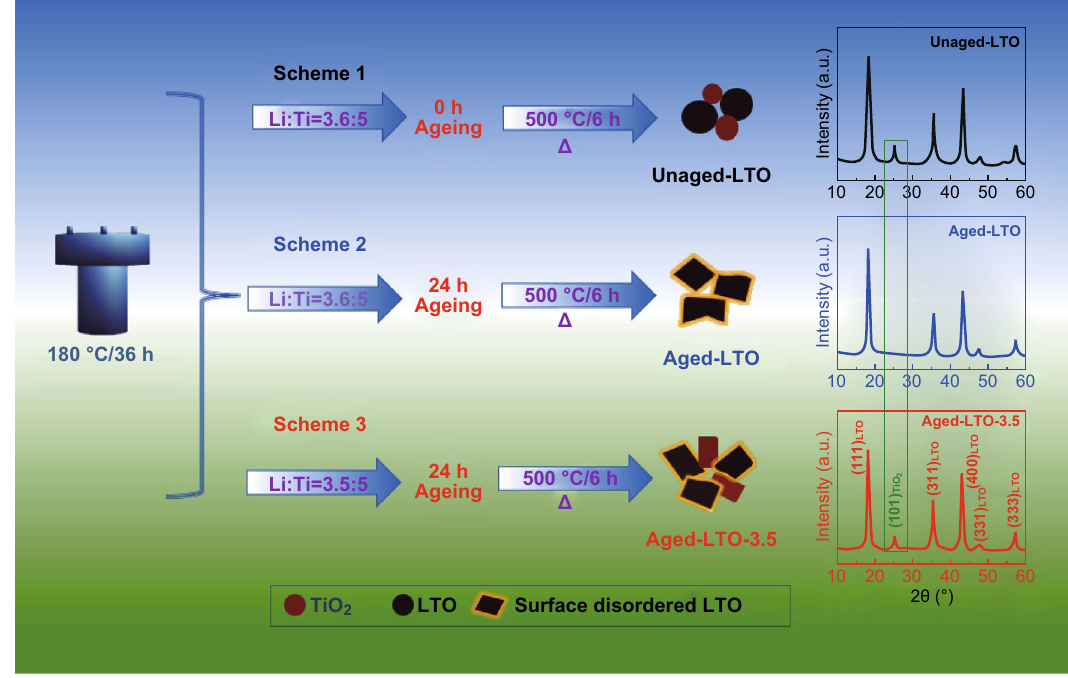
Fig. 1 Solvothermal Schemes 1–3 with the physical and chemical characteristics of the unaged LTO, aged LTO, and aged LTO-3.5 samples and their XRD